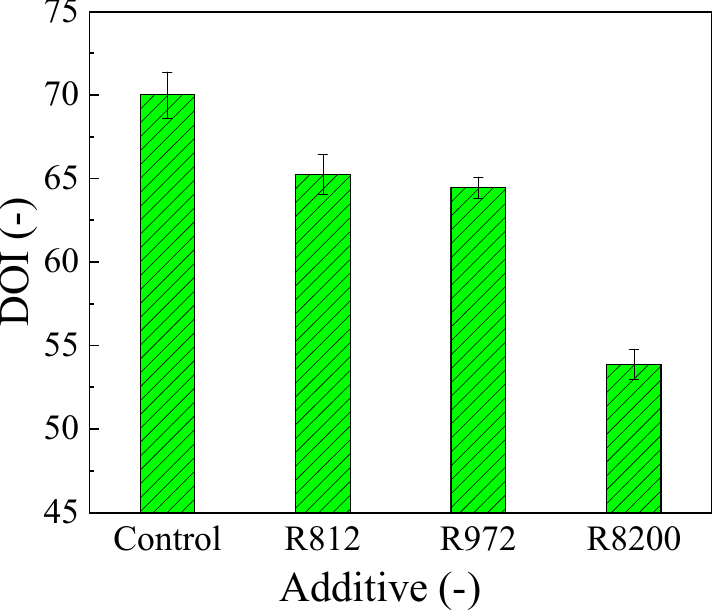
Figure 13. DOI of powder samples films.